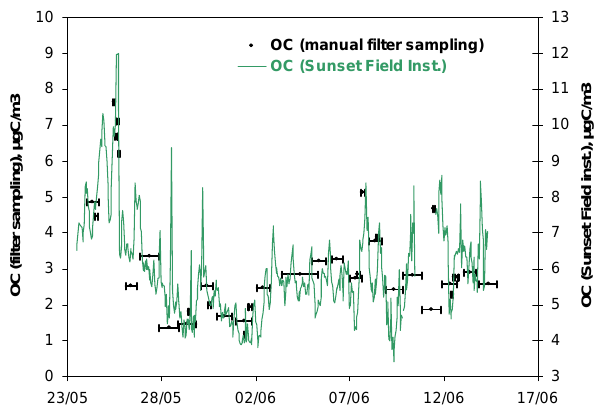
Fig. 2. Hourly reconstructed ions concentrations derived from Eq. (2) and ions concentrations (ammonium nitrate and ammonium sulfate) from manual filter sampling. Horizontal bars stand for the duration of the filter